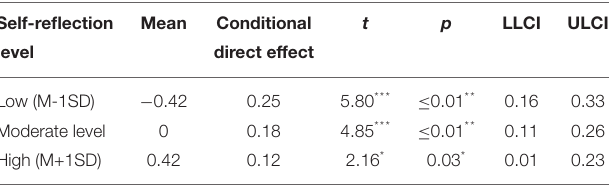
TABLE 5 | Results of the conditional direct effect of perceived parental academic expectation on students’ SRL ability across different levels of self-reflection. Self-reflection